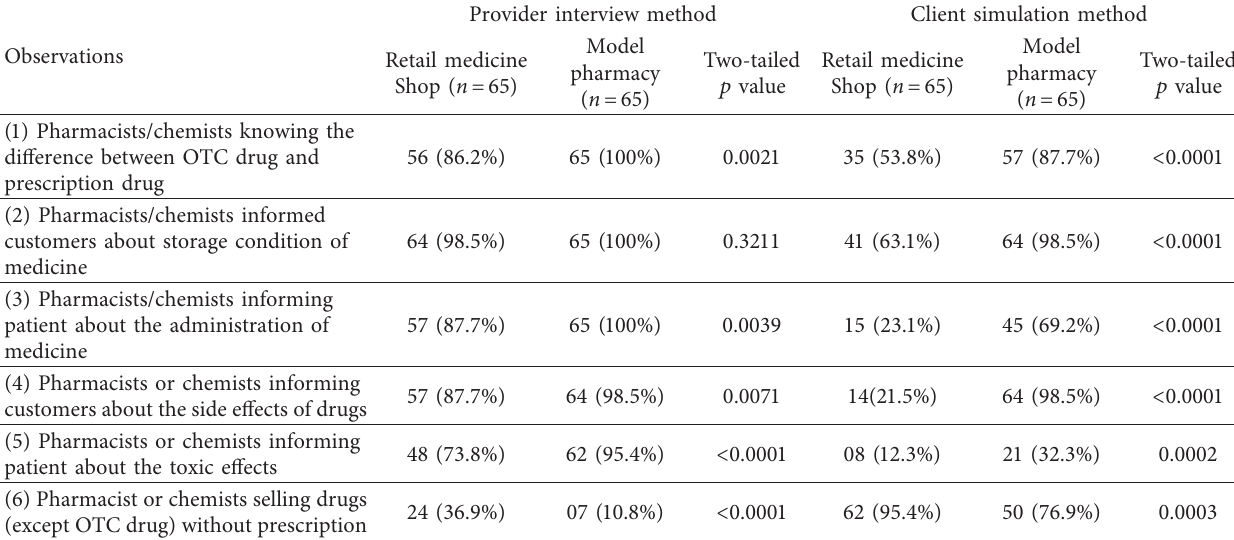
Table 3: Knowledge- and practice-based output from dispensers (A-, B-, and C-grade pharmacists/chemists/owner or manager/salespeople) from retail medicine shops and model